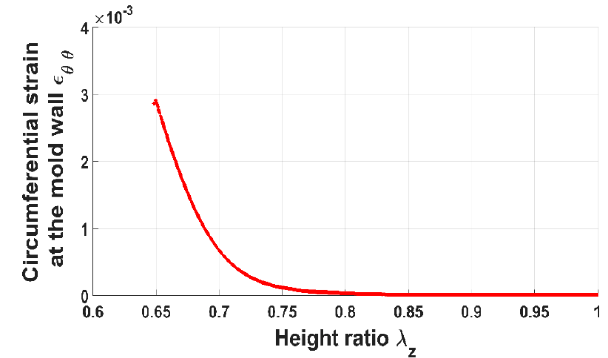
Figure 4. Axial pressure vs. height ratio.